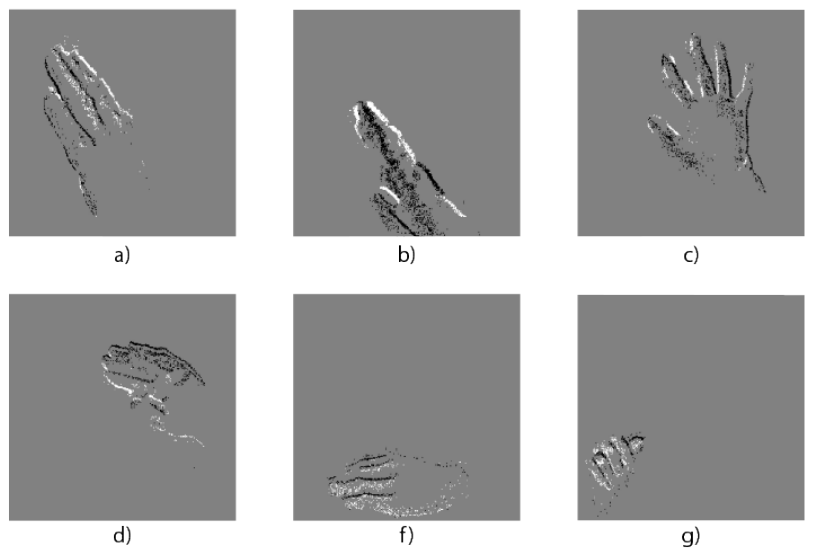
Figure 8. Hand gestures from ( a – g ): Left, Right, Hello Hand, Up, Down,